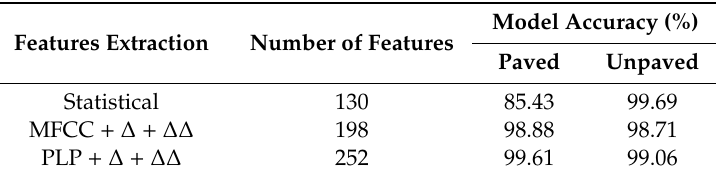
Table 7. Results from di ff erent vehicle